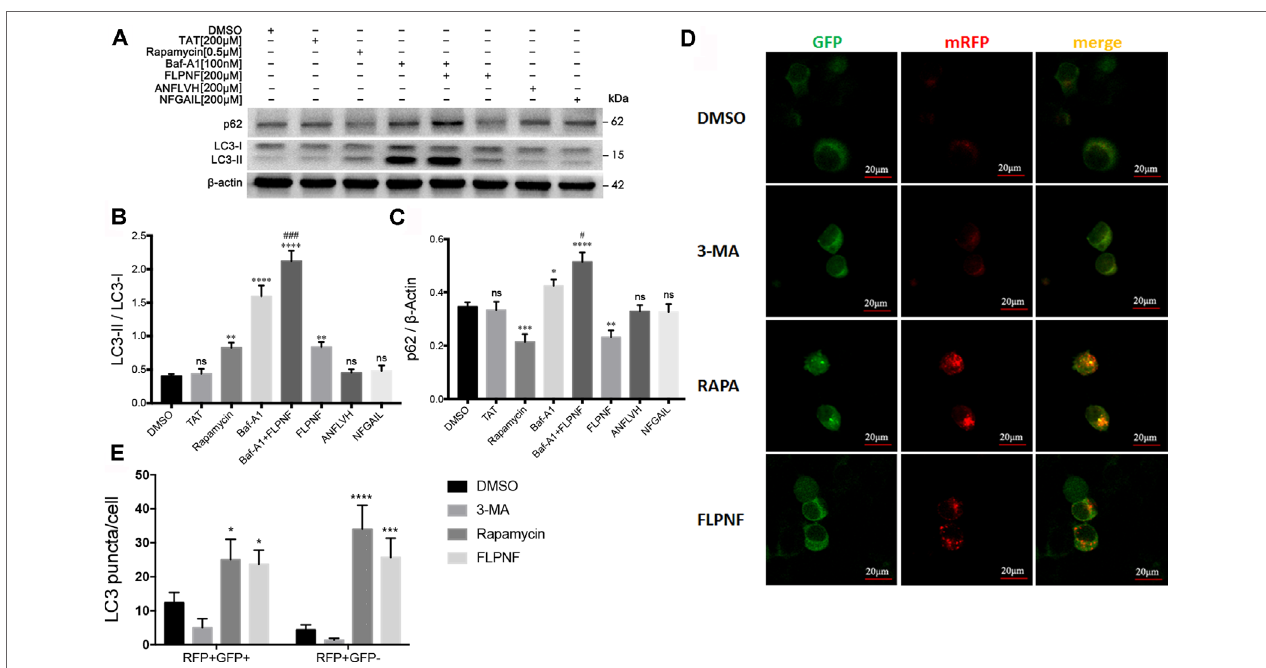
FIGURE 3 | Peptide FLPNF significantly induces the autophagy flux in hIAPP-INS-1 cells. (A) Protein levels of LC3 and p62 were assessed by Western blot in hIAPP-INS-1 cells after exposure to 200 μM peptide FLPNF for 24 hours. Autophagosome-lysosome fusion inhibitor bafilomycin-A1 (100 nM) was used to confirm the peptide FLPNF-induced autophagy flux. (B) and (C) The graph represents the quantification of LC3-II and p62 protein levels, respectively (n = 4). * p < 0.05, ** p < 0.01, *** p < 0.001, **** p < 0.0001, and ns vs. DMSO group. # p < 0.05 and ### p < 0.001 vs. Baf-A1 group. (D) Representative confocal fluorescent images of hIAPP-INS-1 cells-expressing mRFP-GFP-LC3. Yellow puncta represent autophagosomes and red puncta for autolysosomes, which were quantified in the (E) (n = 4). * p < 0.05, *** p < 0.001, and **** p < 0.0001 vs. DMSO